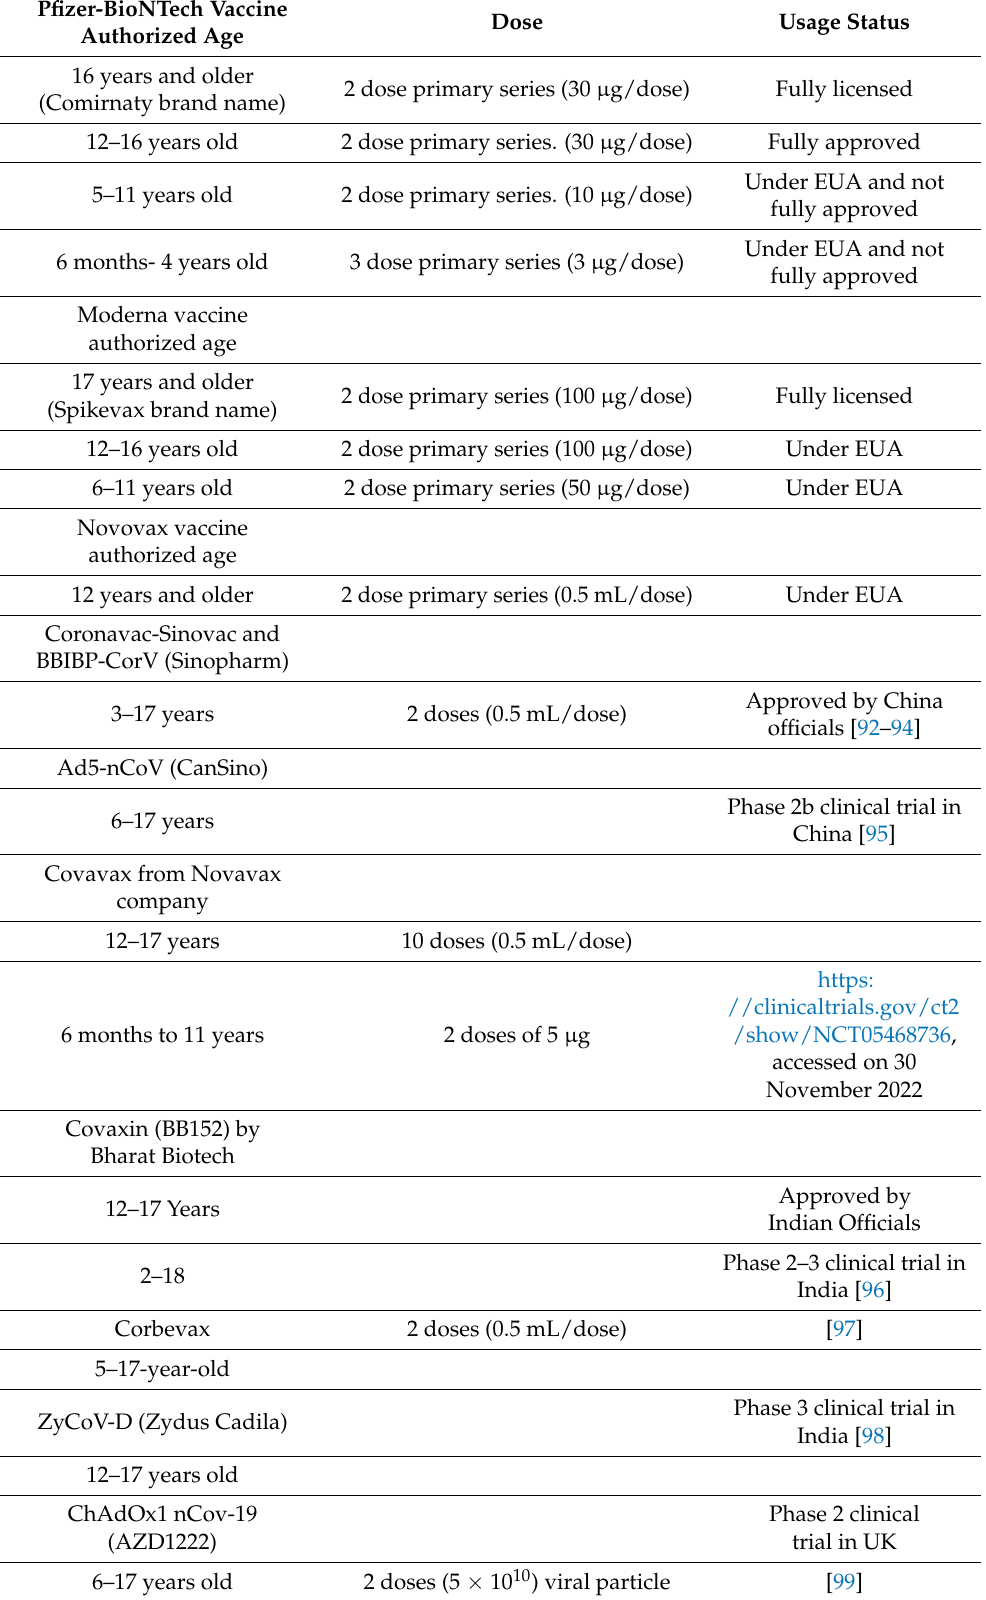
Table 3. COVID-19 vaccine doses and status for different age groups. Pfizer-BioNTech